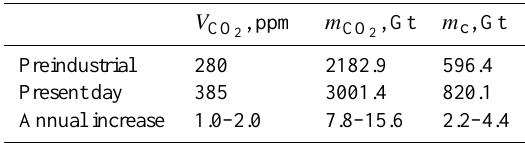
Table 2. The volume mixing ratio of CO 2 in the atmosphere ) , the mass of CO 2 ( m CO ( V CO 2 ( m c )